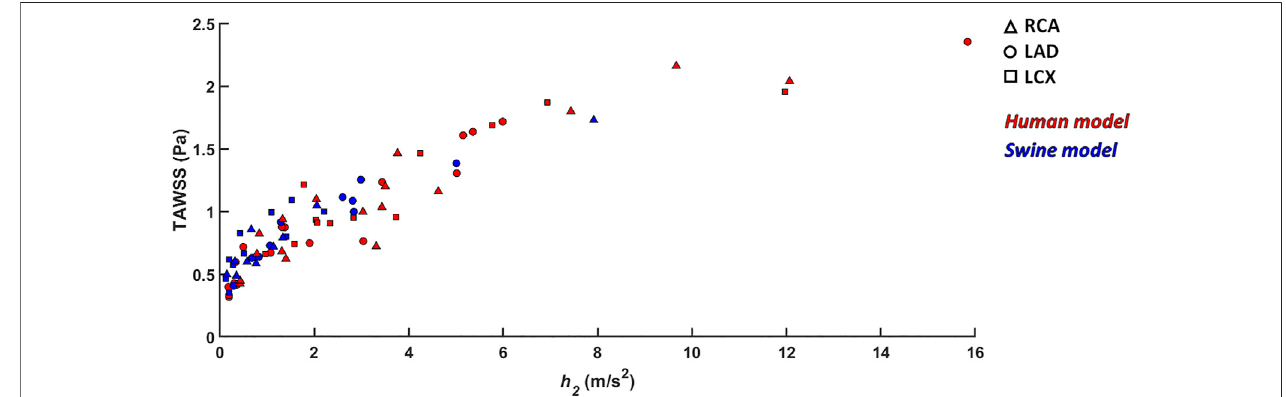
FIGURE 10 | Scatter plots of helicity intensity h 2 vs TAWSS. Red color indicates human models; blue color indicates swine models. Right (RCA), left anterior descending (LAD), and left circum fl ex (LCX) coronary artery geometries are distinguished by marker